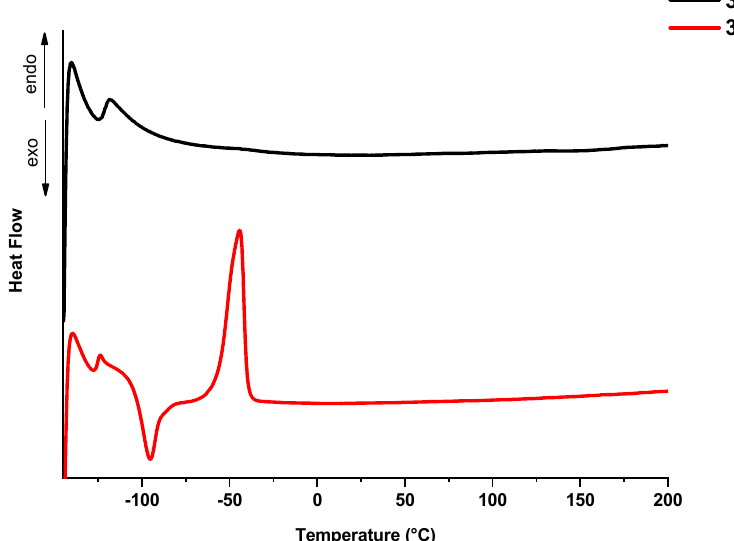
Figure 13. DSC curves for polymers 3 a,b at a heating rate of 10 °C/min. TMA analysis of polymers 3 a,b showed that in TMA curves of all samples, a defor- mation which was associated with the transition from the glassy state to the highly elastic state and then to the viscous flow state is observed (Figure 14). The start of the transition to a viscous flow state for polymer 3 a was observed at a higher temperature (about 40 °C) than in the case of polymer 3 b (about 20 °C).